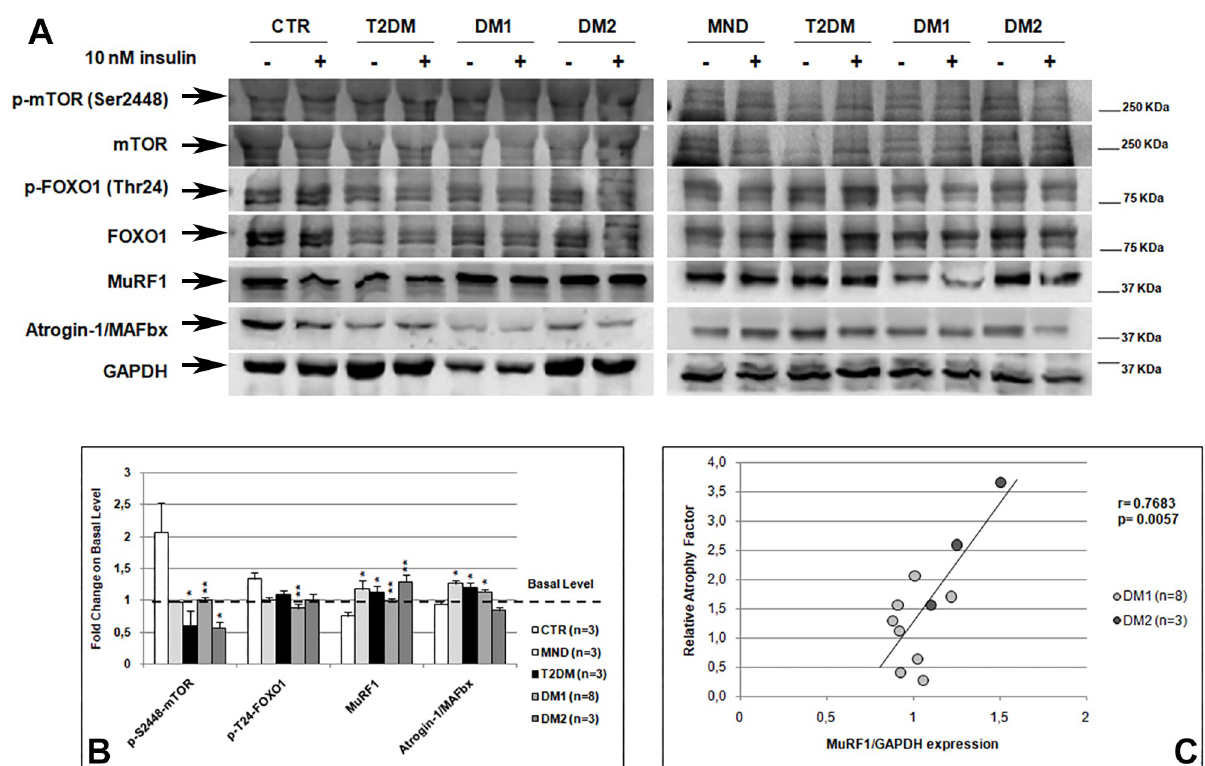
Fig 4. Insulin dependent regulation of skeletal muscle mass. (A) Representative western blot analysis of the expression and phosphorylation of proteins involved in insulin dependent regulation of protein metabolism. Skeletal muscle samples were incubated in absence (-) or presence (+) of 10 nM insulin for 20 minutes. Due to the high number of samples analysed, the figure panel is composed by images of two different gels. Details on how western blot experiments were performed are reported in Materials and Methods. (B) Fold change on basal level of the quantification of mTOR and FoxO1 activation and of MuRF1 and Atrogin-1/MAFbx expression. Histograms represent mean values and bars represent standard error of the mean (SEM). The number of samples analysed in each group (n) is reported in the graphic legend. Density of MuRF1 and Atrogin-1/MAFbx bands have been normalized to GAPDH expression. Differences between groups have been evaluated by Student t -test. � p < 0.05; �� p < 0.01. (C) Pearson’s correlation between the relative atrophy factors and MuRF1 expression in DM patients.